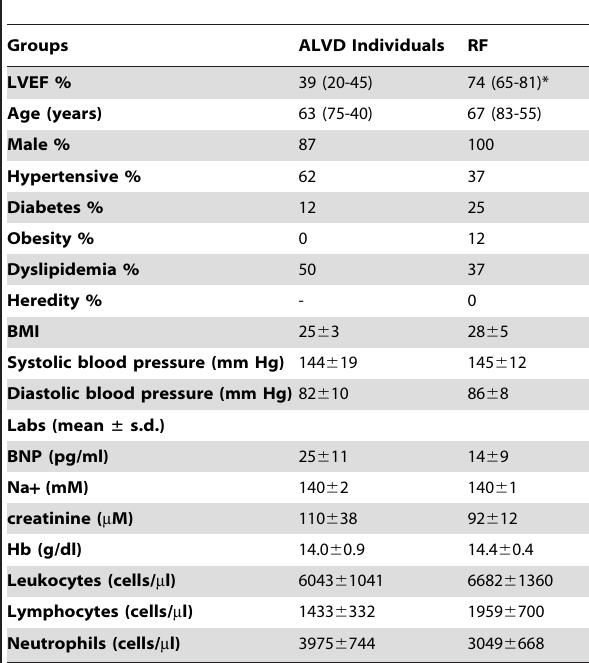
Table 3. Cardiovascular risk factors, clinical and biochemical parameters of the ALVD validation group (n=8) and RF individuals (n=8).